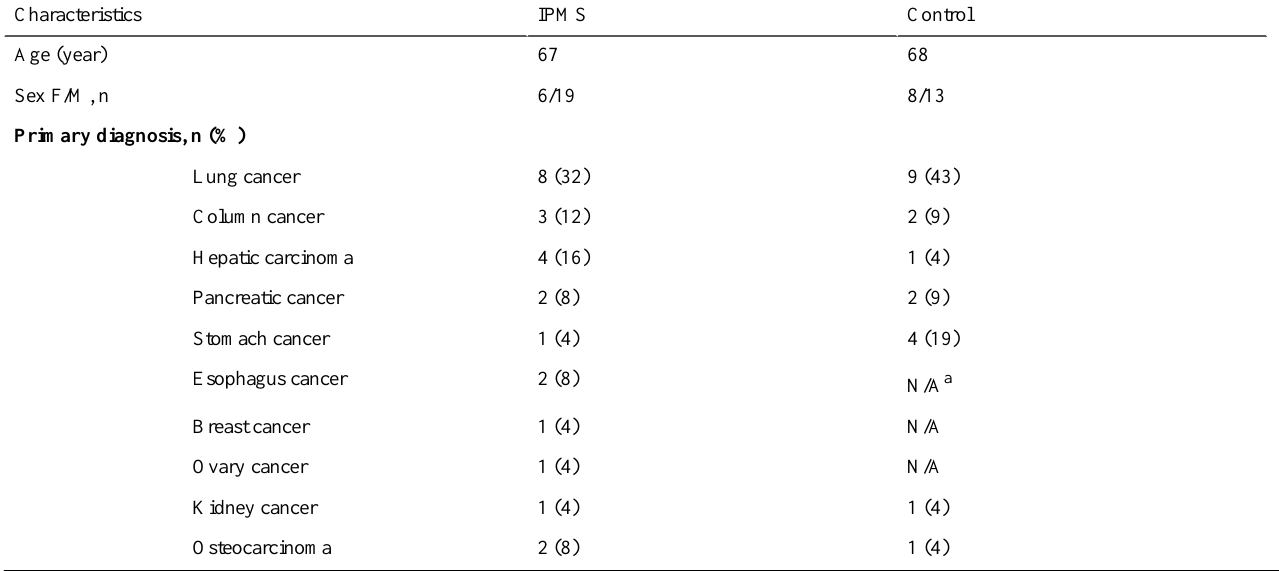
Table 2. Demographics and disease characteristics of